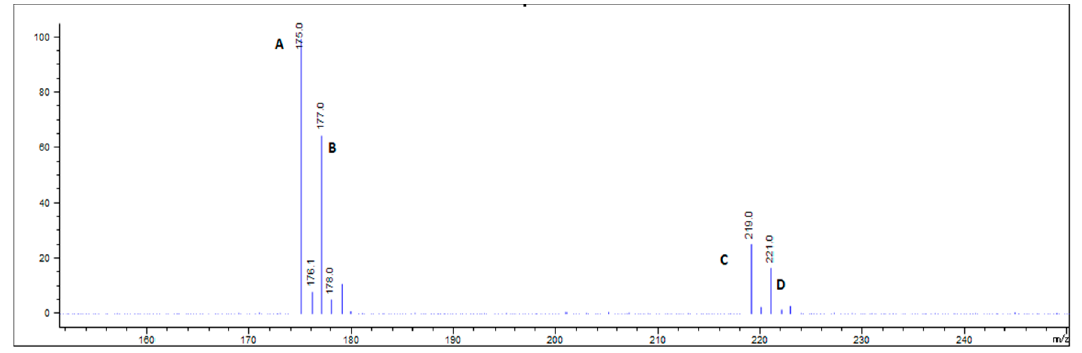
Figure 3. Mass spectrometry (MS) full scan spectrum of dicamba analytical standard showing isotopic pattern corresponding to 35 Cl m / z 175 (A) and m / z 219 (C), and 37 Cl m / z 177 (B) and m / z 221 (D).